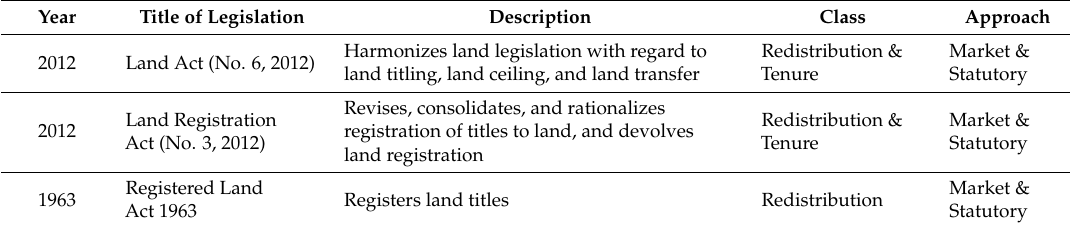
Table 3. Selected pieces of postcolonial land legislation in